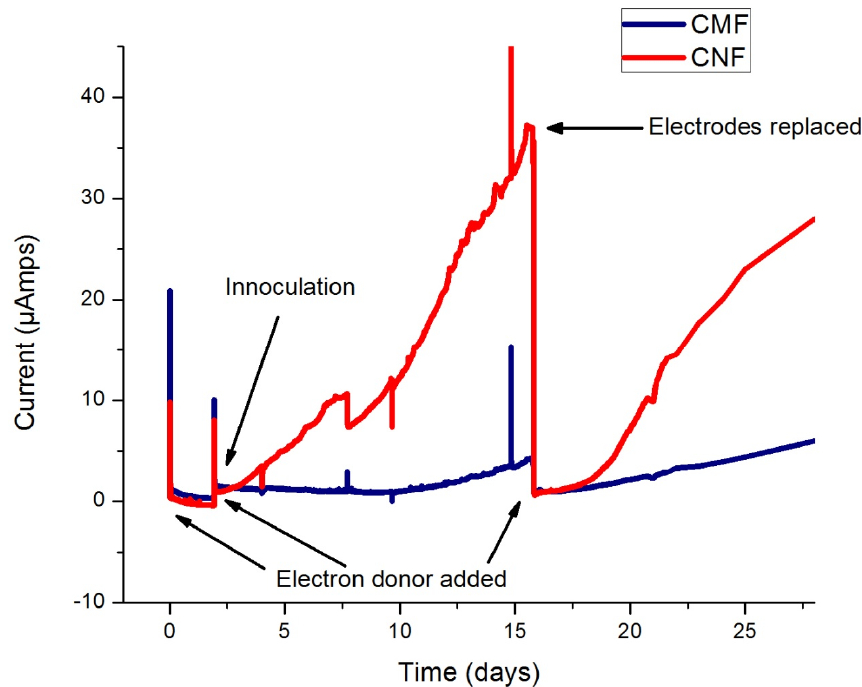
Figure 1. Amperometric data from a MEC inoculated with Shewanella oneidensis MR-1 . Current production by carbon nanofiber mats/CNF (red) and carbon micfiber paper/CMF (blue) was monitored over a 4 week